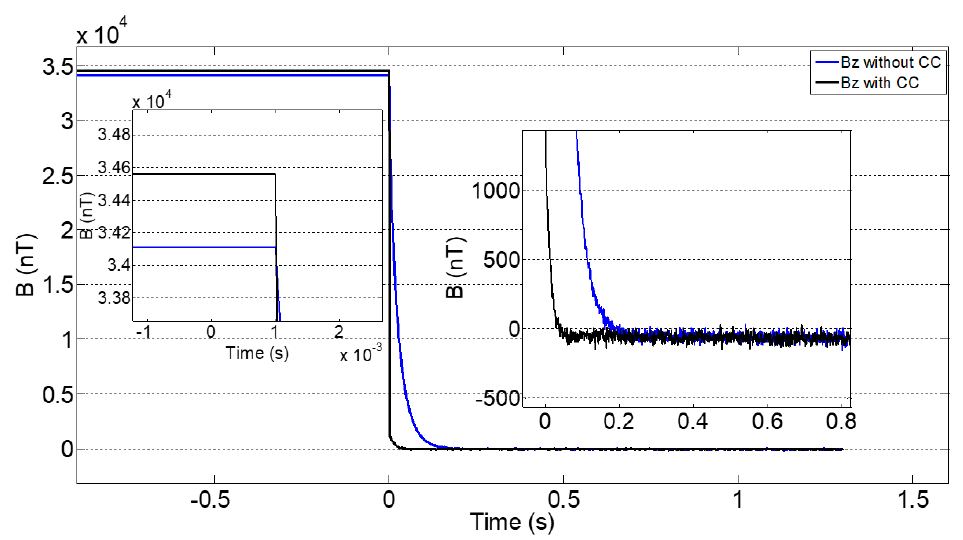
Figure 9. Comparison of the residual magnetic fields in z-direction without and with CC.